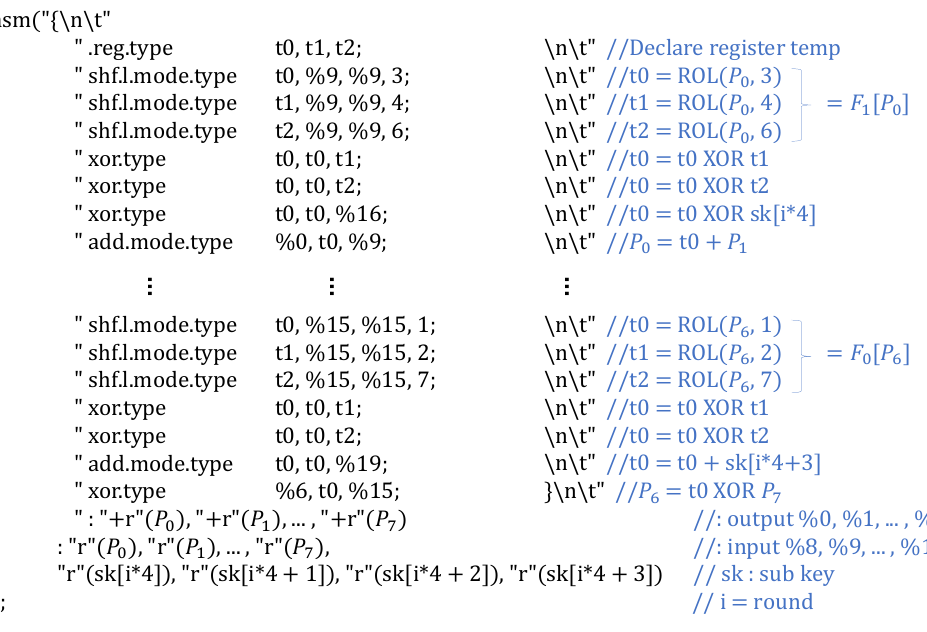
Figure 12. Example of inline PTX assembly codes of HIGHT round